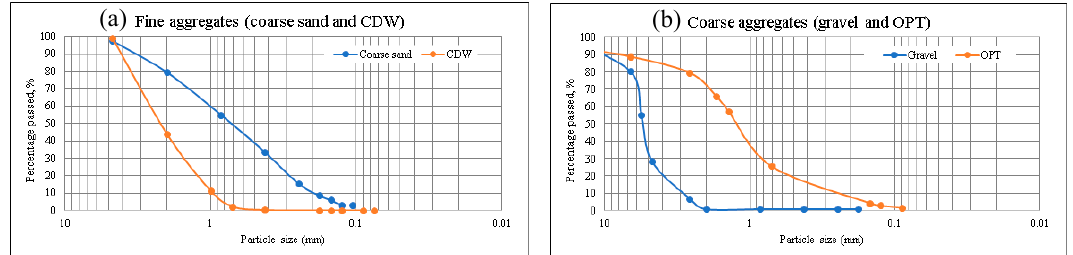
Figure 1. The particle size of the raw materials: ( a ) fine aggregates; ( b ) coarse aggregates.